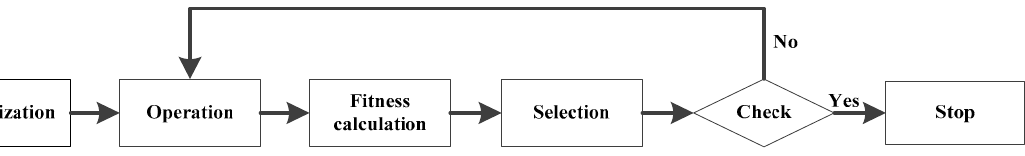
Figure 1. Optimization algorithm with evolutionary algorithms (EAs) as the optimization engine.